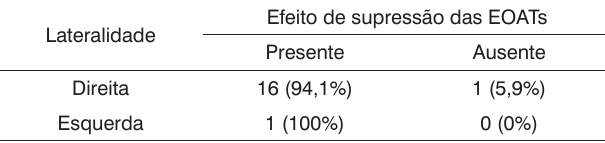
Tabela 3. Lateralidade e ocorrência do efeito de supressão das EOATs na orelha